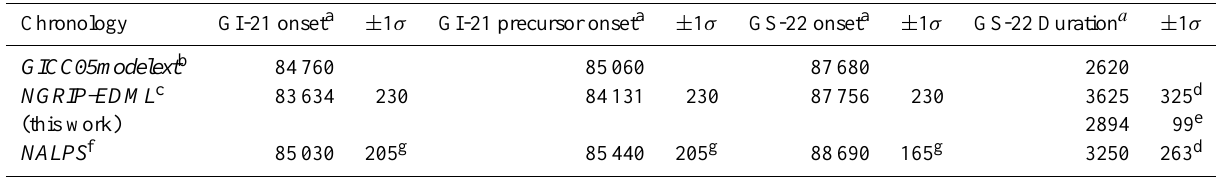
Table 1. Summary of absolute ages of onset and end transitions associated with GS-22, and calculated durations from various NorthGRIP ice core chronologies as well as the NALPS speleothem record.